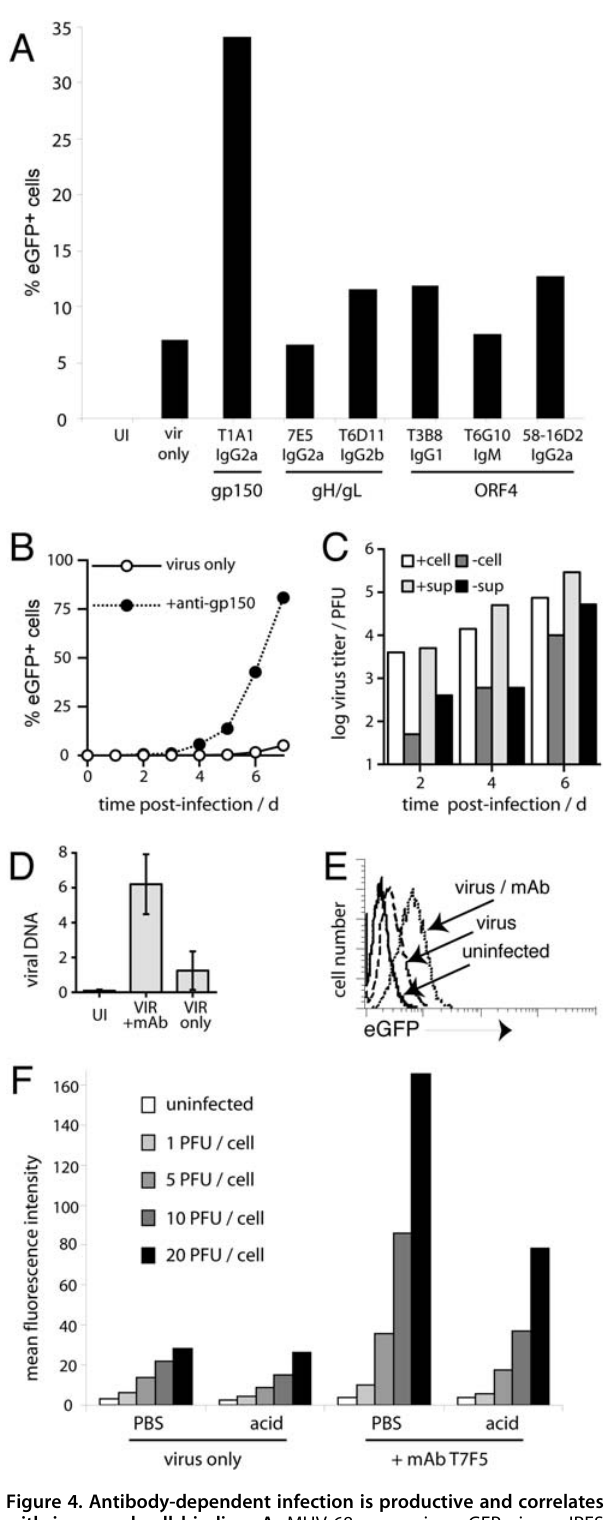
Figure 4. Antibody-dependent infection is productive and correlates with increased cell binding. A. MHV-68 expressing eGFP via an IRES inserted downstream of ORF73 was incubated with viral glycoprotein- specific mAbs as shown (100 m g/ml) and then incubated with RAW264.7 cells (5PFU/cell). UI=uninfected; vir only=virus without antibody. 18 h later viral eGFP expression was quantitated by flow cytometry. The data are from 1 of 3 equivalent experiments. B. BAC + MHV-68 was incubated with the gp150-specific mAb T4G2 (20 m g/ml) or with medium alone (1 h, 37 u C) and then added to RAW264.7